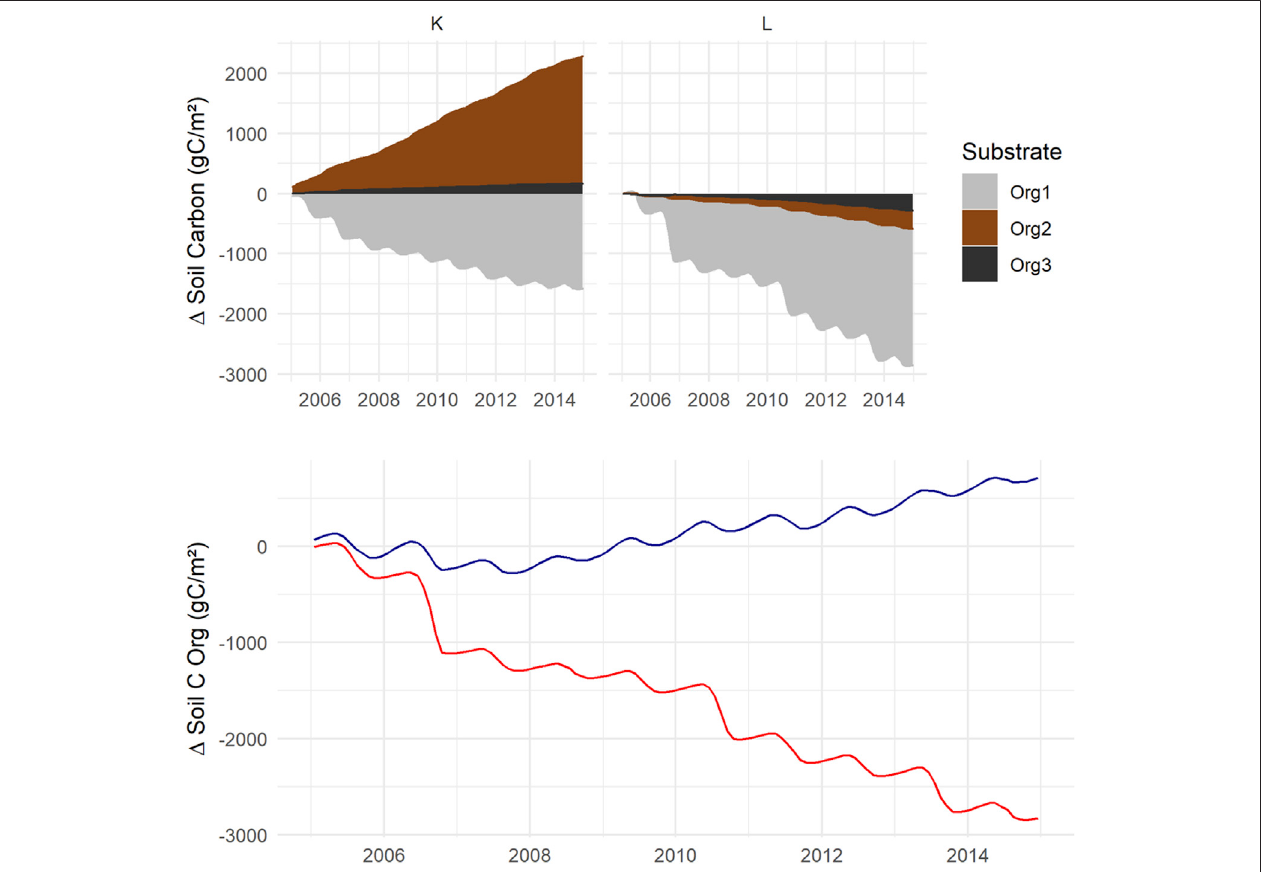
FIGURE 8 | Simulated change in soil C pools where positive numbers shows the accumulation. Top panel shows the change in SOC1 (cid:1) grey, SOC2 (cid:1) brown and SOC3 (cid:1) black. Bottom panel shows the total soil C accumulation for scenario K (cid:1) blue and L (cid:1) red. Mean of 100 accepted model runs ( Supplementary Table S10-a ).